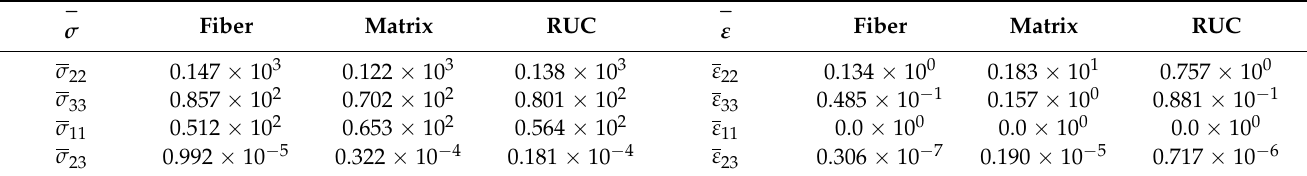
Table 3. Average values of stress and strain (Case